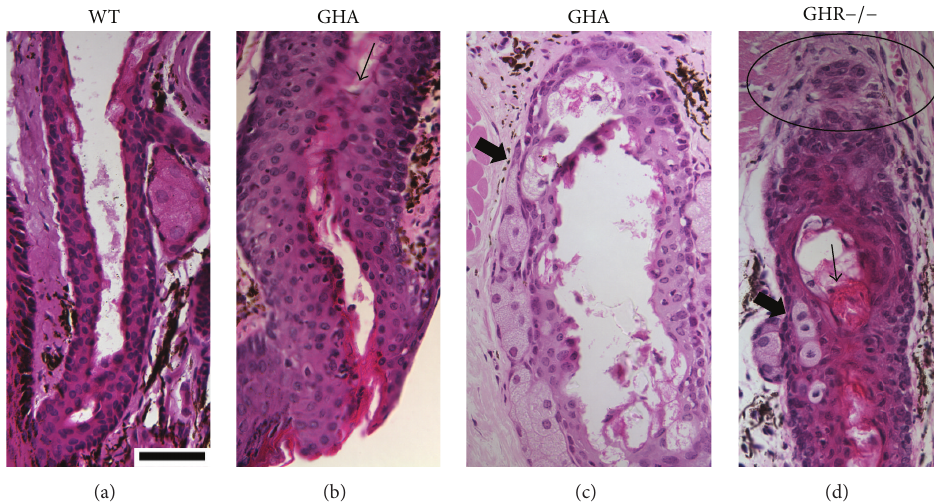
Figure 1: Meibomian gland morphology in male WT, GHA, and GHR − / − mice. (a) is from a WT mouse. (b) and (c) are from GHA mice. (d) is from GHR − / − mice. In (b) and (d), the arrows point to the cornified materials in the ducts. In (c) and (d), the thick arrows point to the secretory acini inserting into duct walls. In (d), the circle indicates possible gland dropout. All slides were stained with H & E, and the magnifications are 400x. The size bar in (a) is 50 𝜇 m in length.